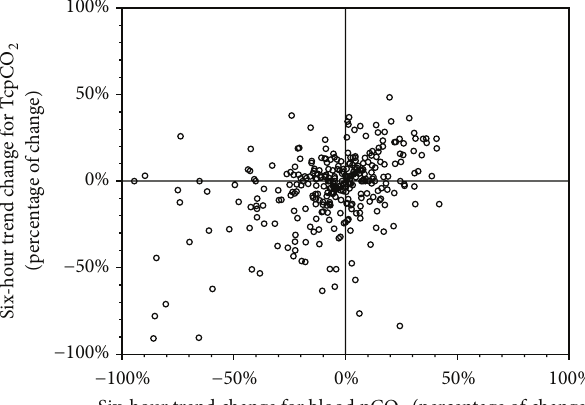
Figure 3: Scatter plot of the changes in blood pCO 2 and the TcpCO 2 six-hour trends. Scatter plot of the changes in blood pCO 2 ( 𝑥 -axis) and the TcpCO 2 ( 𝑦 -axis) six-hour trends. 𝑛 = 313 pairs. Pearson’s 𝑅 = 0.25 ; 𝑝 < .001